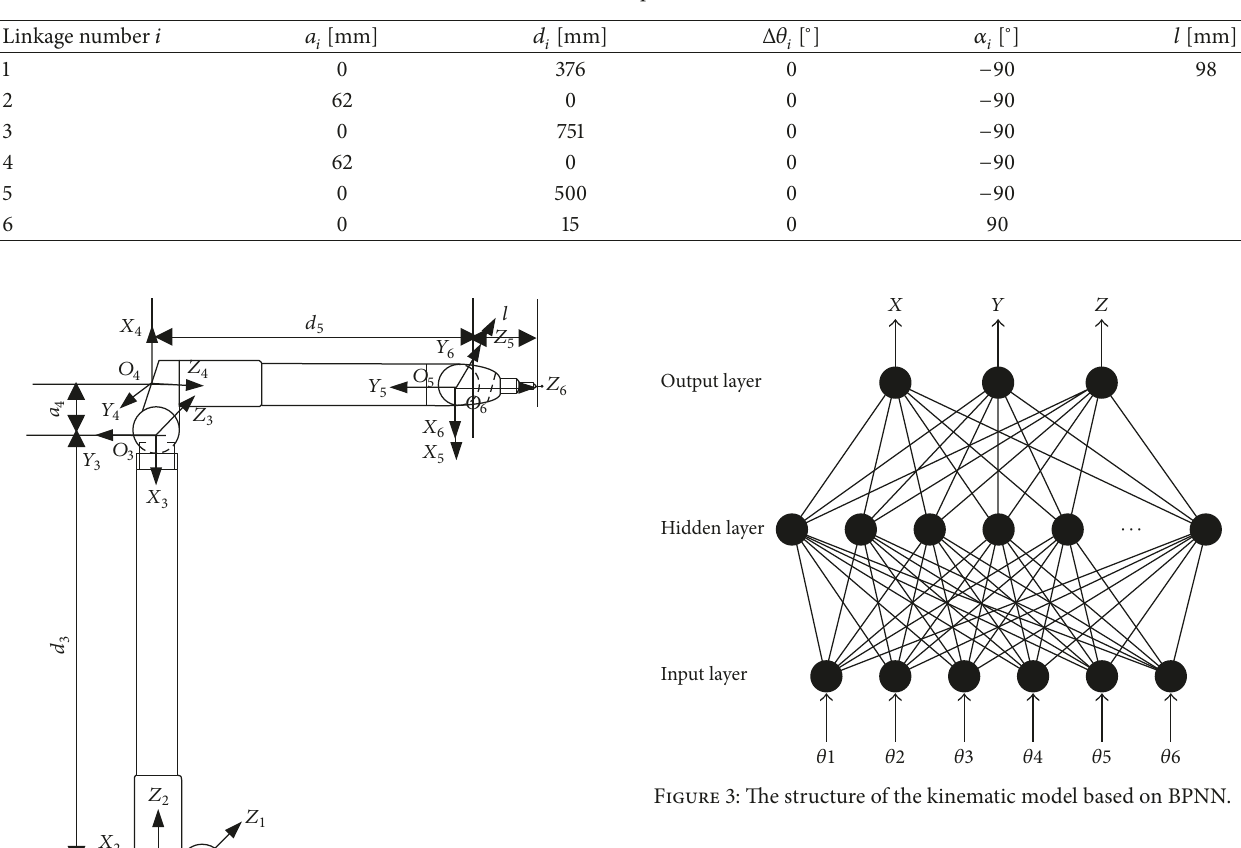
of the neurons in each hidden layer will be determined by using optimization methods in Sections 3 and 4. The neurons between the layers are all fully